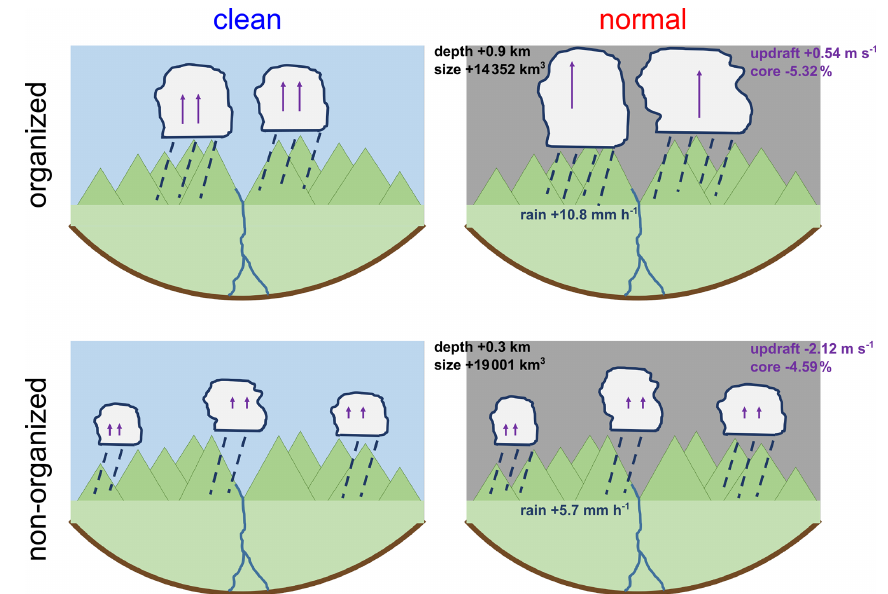
Figure 9. The schematic diagram summarizes the influence of CCN on the mature stage of the diurnal precipitating systems over complex topography. The values in the normal scenario are the increment due to increasing CCN of the P 99 of the maximum rain rate, cloud depth, cloud size, in-cloud vertical velocity, and core